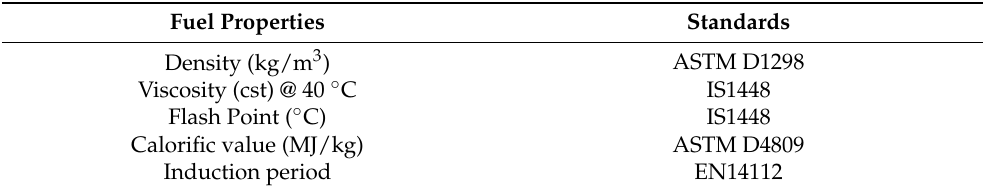
Table 2. Fuel characteristics of the prepared